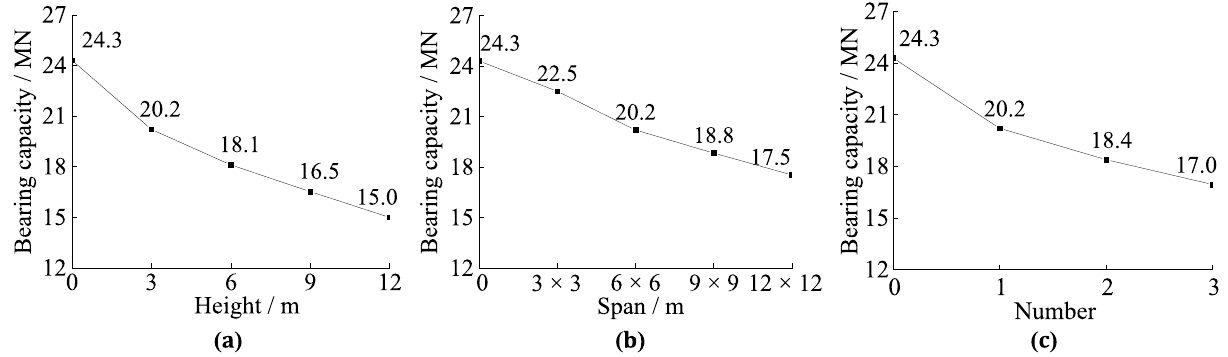
Figure 2. The ultimate bearing capacity of piles under three factors: ( a ) ultimate bearing capacity under different cave’s height; ( b ) ultimate bearing capacity under different cave’s span; ( c ) ultimate bearing capacity under different cave’s number.